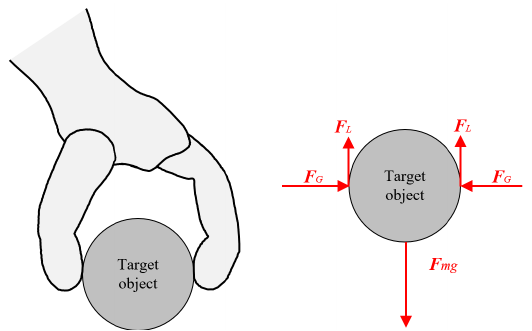
Figure 1. Schematic of grasping model based on Coulomb’s friction.